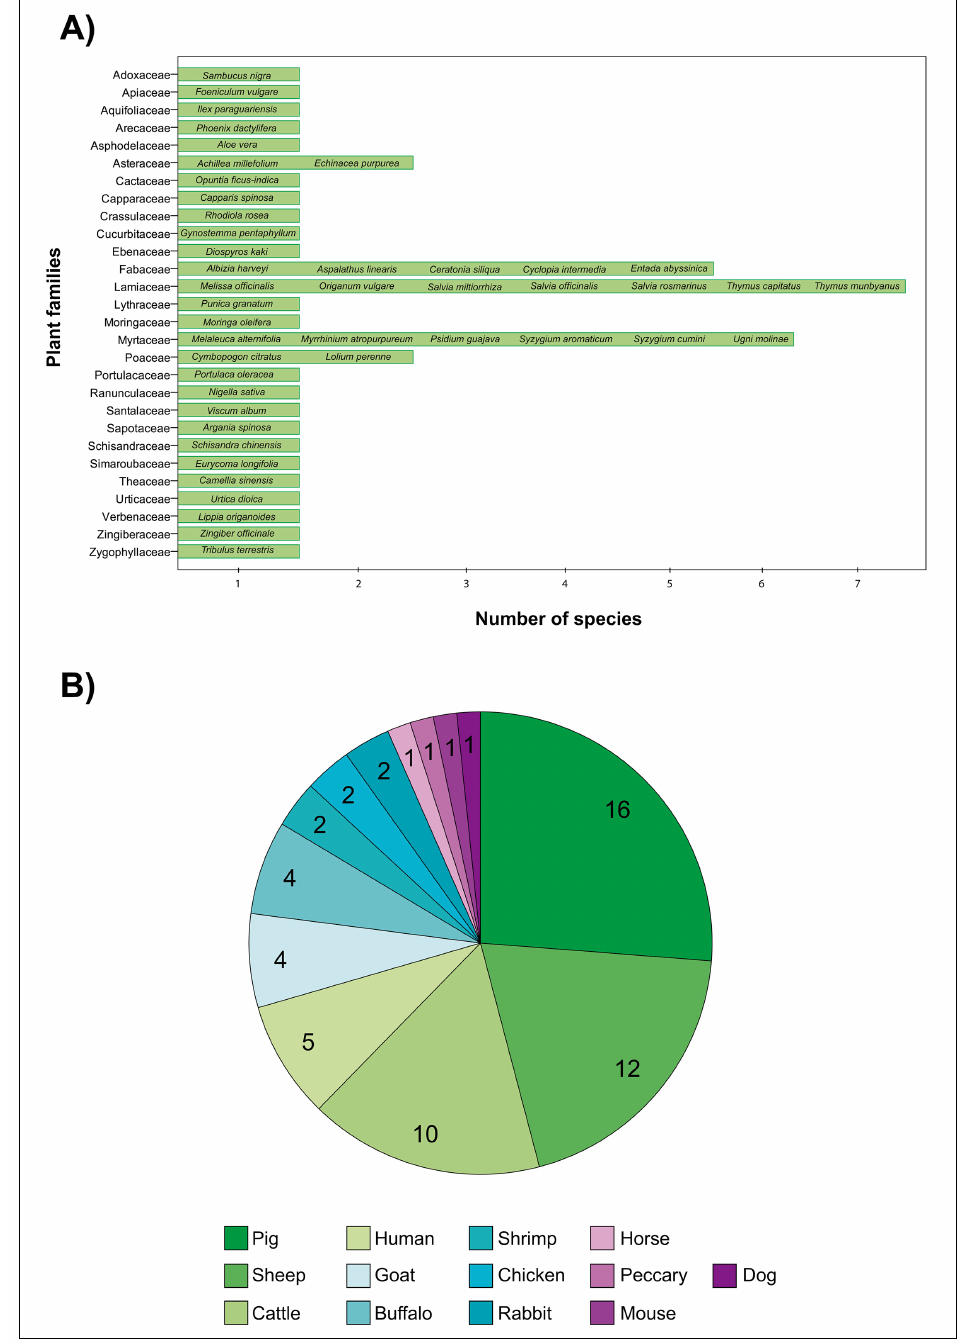
Figure 1. ( A ) Plant families ( N = 28) and species ( N = 45) overviewed in the present work. ( B ) Number of plant species tested in the spermatozoa from different animal species.